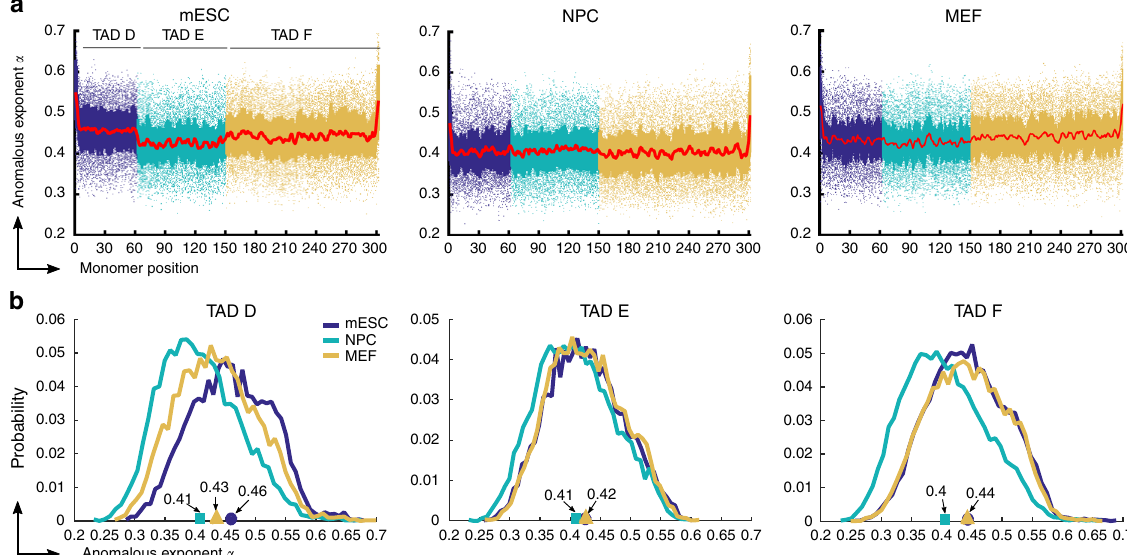
Fig. 4 Anomalous exponents in three stages of differentiation. a Anomalous exponents computed for 302 monomers of the RCL polymer reconstructed in Fig. 2, corresponding to 5C data of three TADs, TAD D (dark blue), TAD E (cyan), and TAD F (brown) of the X chromosome 1 . A hundred realizations are simulated for each con fi guration using Eq. (17). For each realization, we choose the positions of added connectors uniformly distributed within and between TADs and repeated simulations 100 times, after relaxation time has been reach (Supplementary Methods Equation 23). We then run simulation for 25 s. The anomalous exponents α i , i = 1, … , 302 are obtained by fi tting the MSD curve of each monomer using model 10. b Distribution of the anomalous exponent in TAD D (left) TAD E (middle), and TAD F (right) for three cell stages: mESC (dark blue), NPC (cyan), and MEF (brown). The average anomalous exponents in TAD D, E, and F, are α D = 0.46, 0.41, 0.435, α E = 0.425, 0.41, 0.426, and α F = 0.443, 0.405, 0.44 for mESC (circle), NPC (square), and MEF (triangle) stages,